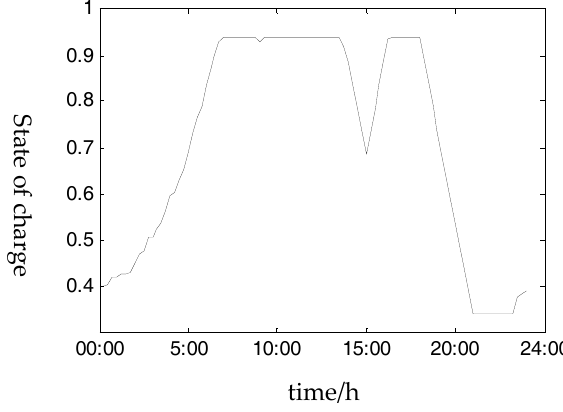
Figure 5. Charge and discharge state of a battery for one day.